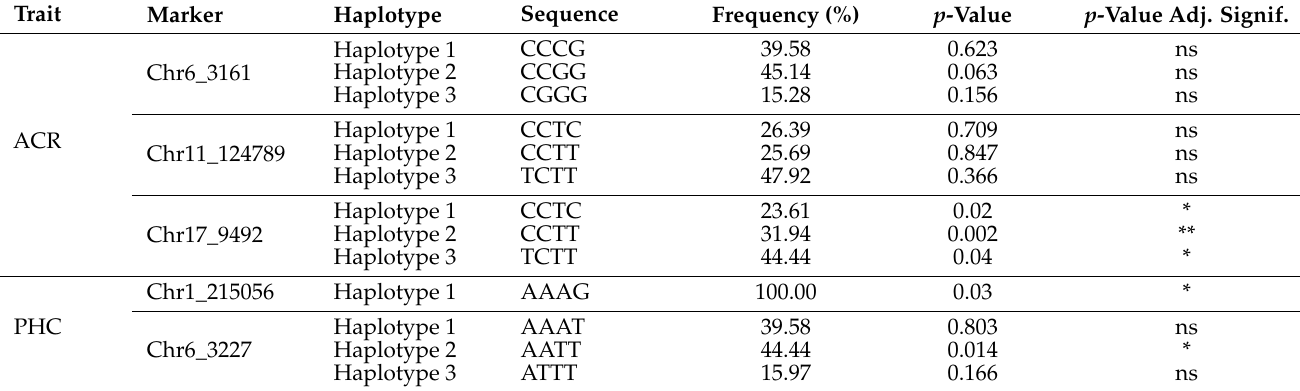
Table 3. Haplotype segregation for the markers associated with ACR and PHC in D. alata .